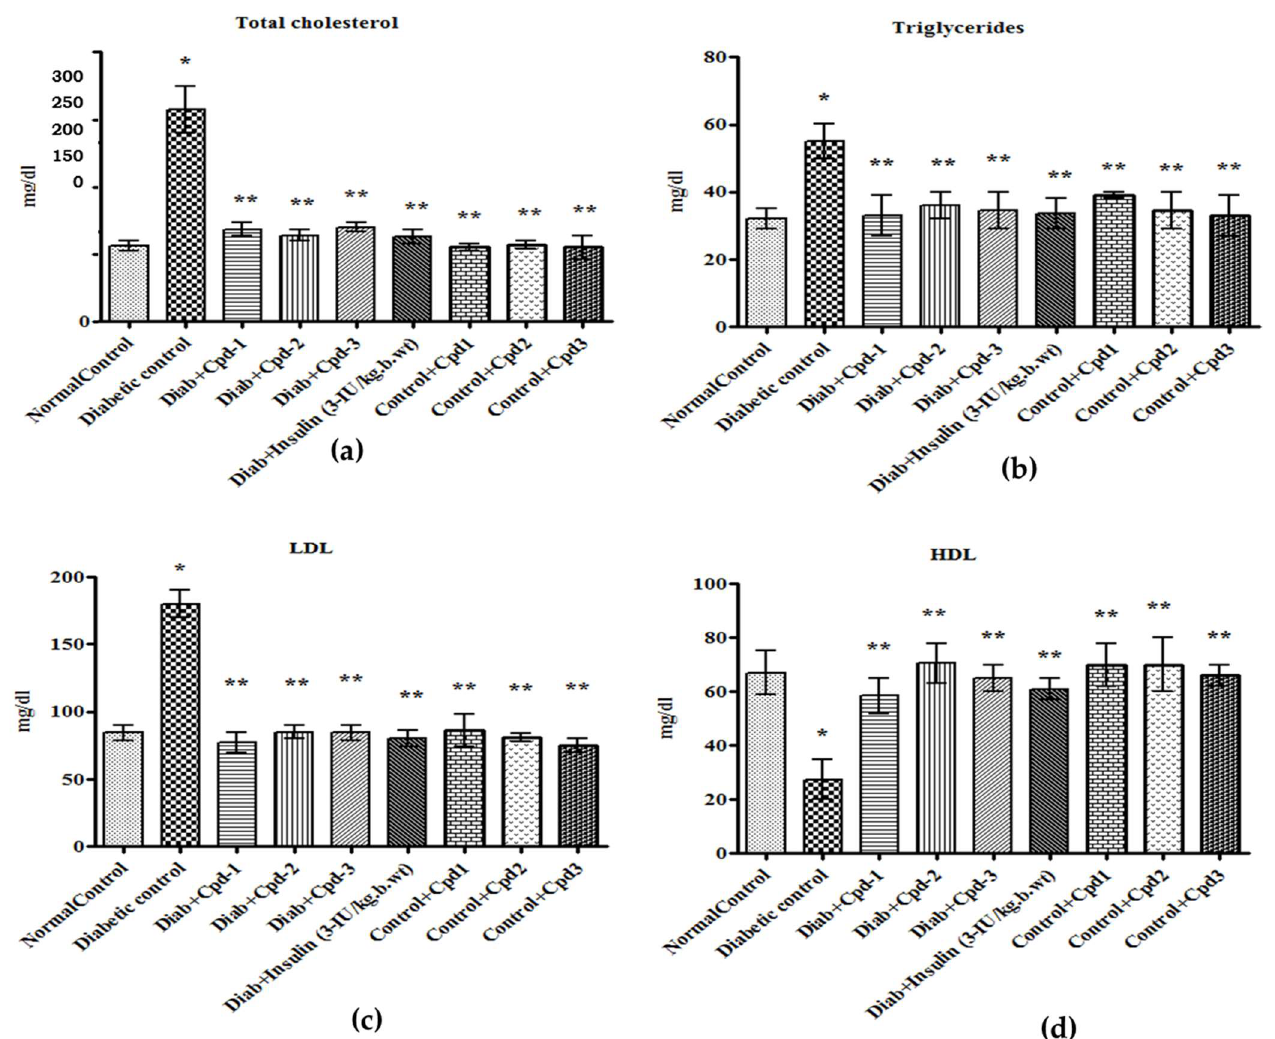
Figure 5. Effect of novel triterpenoids on ( a ) TC; ( b ) TG; ( c ) LDL; ( d ) HDL in STZ-induced diabetic rats compared with the effect of insulin. Each bar represents mean ± SEM of 6 animals. Significance at p < 0.05; *, compared with control; **, compared with diabetic control.